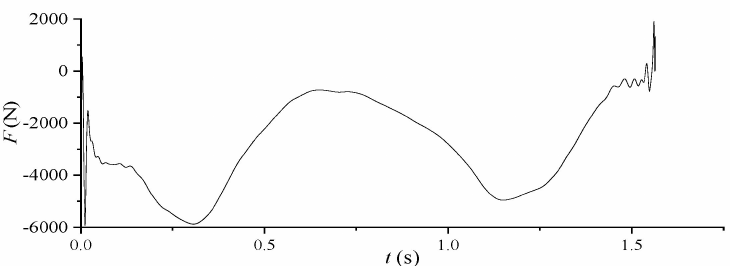
Figure 12. Identifying contact force at a speed of 20 km/h. Note: positive is pull and negative is press, the same as